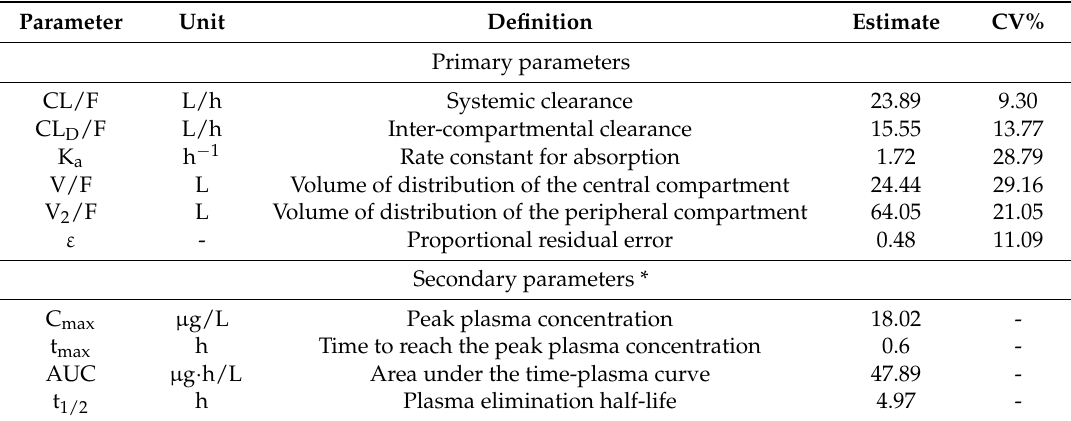
Table 4. Model estimated pharmacokinetic (PK) parameters of